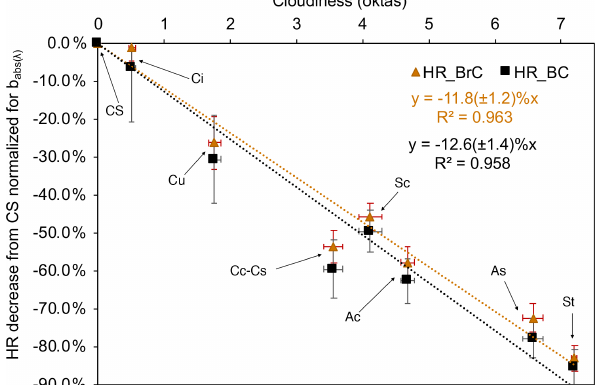
Figure 16. Percentage decrease of the HR BC and HR BrC with re- spect to clear-sky conditions as a function of cloudiness (oktas) av- eraged for each cloud